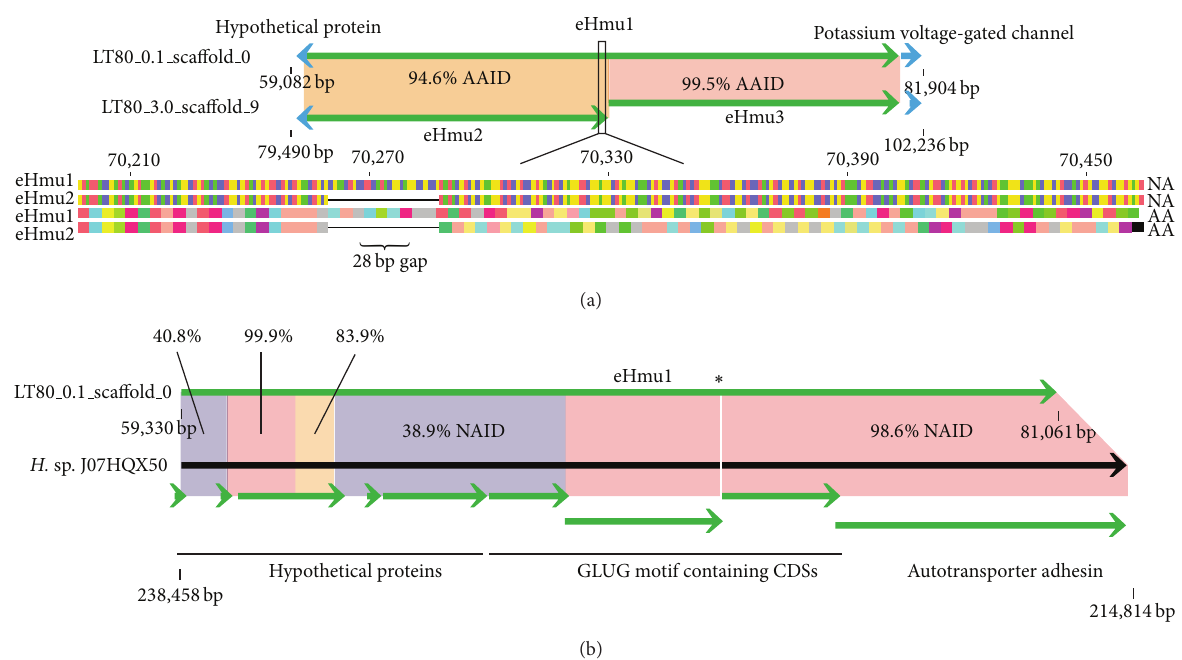
Figure 4: (a) A comparison of halomucin homologs, eHmu1, found on the environmental contig LT80 0.1 scaffold 0 and the corresponding fragments of eHmu2 and eHmu3, found on the contig LT80 3.0 scaffold 9. The section indicated in the black box reveals the nature of the 28 bp deletion within eHmu2 that causes the frameshift resulting in a stop codon approx. 230 bp downstream. AAID: amino acid identity. (b) A comparison of the halomucin homolog eHmu1 and the corresponding region and annotations identified in H. sp. J07HQX50. ∗ represents the location of an 81 bp gap in a GLUG motif containing CDS from H. sp. J07HQX50. NAID: nucleic acid